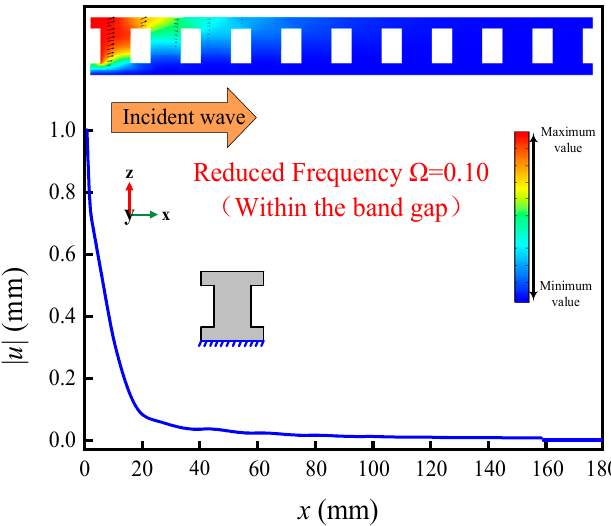
Figure 6. Radial vibration displacement field of the quasi-static REMs.